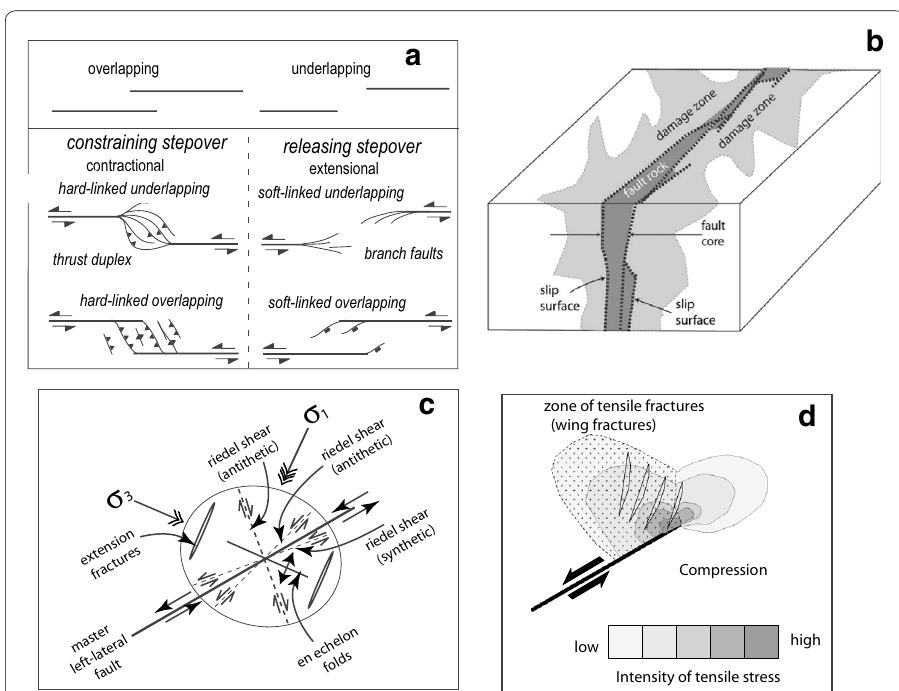
Fig. 26 Models of fracture systems associated with a left-lateral fault (one can use reverse images to view features of a right-lateral fault). a Attributes and features associated with stepover zones (after Micklethwaite et al. 2010). b Internal architecture of a strike-slip fault showing fault core of cataclastic rock, gouge, and slip surfaces, and the surrounding damage zone (after Aydin and Berrymore 2010); c Angular relations of fracture patterns along a left-lateral fault oriented with a 060° strike of the Mae Chan fault. Extensional (open) fractures should parallel the maximum principle stress, σ 1 . The intermediate stress σ 2 is vertically down. The least principle stress is σ 3 . Diagram is from Christie-Blick and Biddle (1985). d Zone of “tensile fractures” (open extensional fractures or cracks) expected at the tip of a left-lateral fault. Kim and Sanderson (2006) call this a zone of “wing cracks” because of the pattern over which they splay near the tip of the fault. For a system that propagates some distance from the fault, the term “wing fractures” may be more appropriate. Diagram based on concepts of fault tips in Gudmundsson (2000), Kim et al. (2004), Kim and Sanderson (2006), and Curewitz and Karson (1997). Pattern of tensile stress at the tip of a left-slip fault is from Reches and Lockner